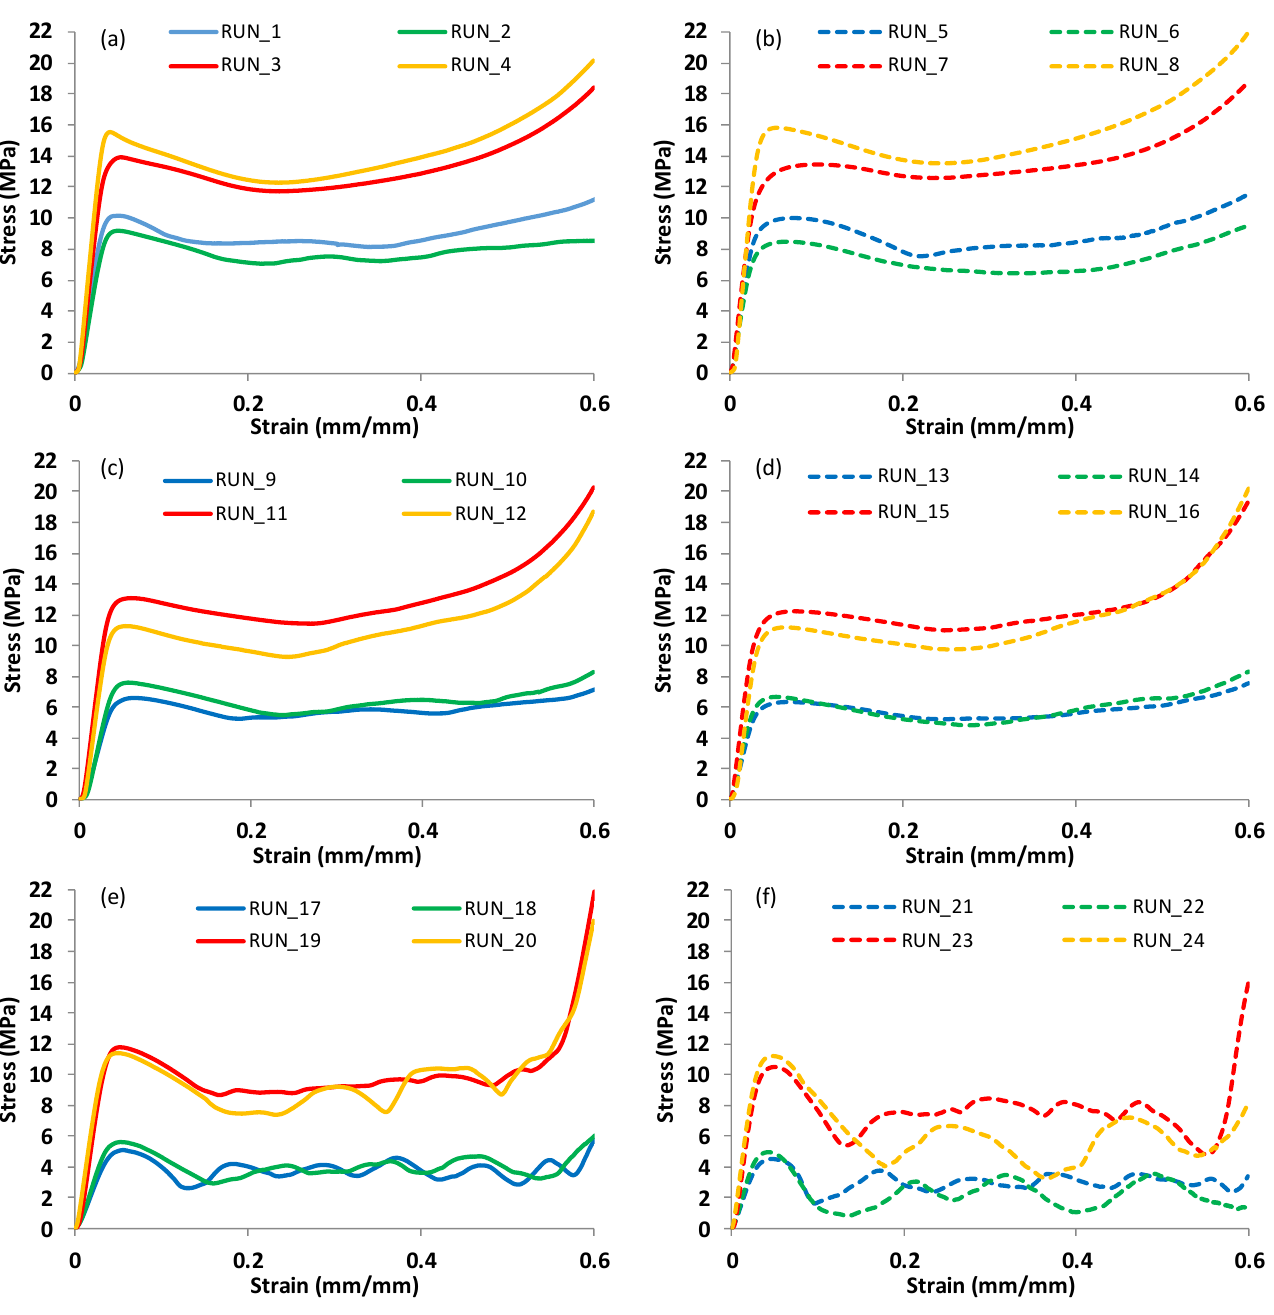
Figure 6. Typical stress-strain curves of the experimental runs listed in Table 4, classified based on the cell type and CF %: ( a , b ) Diamond-based samples at 0% CF and 15% CF, respectively; ( c , d ) Gyroid-based samples at 0% CF and 15% CF, respectively; ( e , f ) Primitive-based samples at 0% CF and 15% CF, respectively.